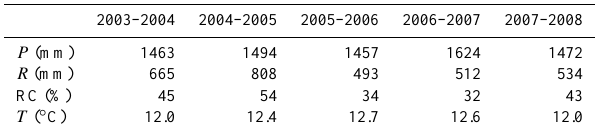
Table 1. Annual precipitation ( P ), runoff ( R ), runoff coefficient (RC), and air temperature ( T ) records for the study